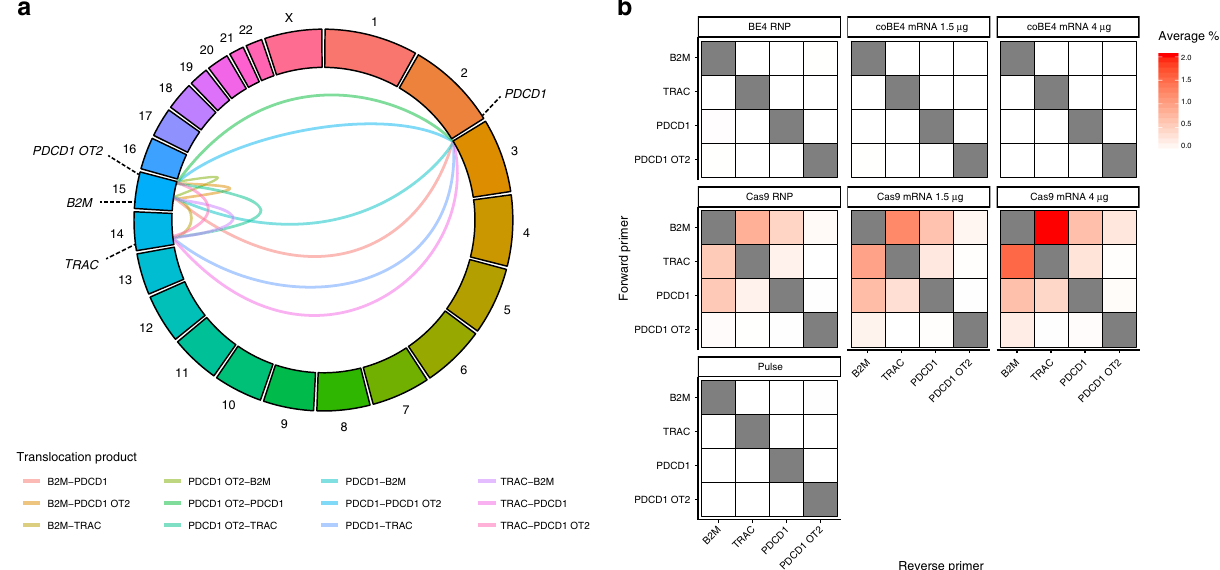
Fig. 3 Translocation frequencies in multiplex edited T cells. a Circos plot of possible translocation outcomes resulting from double-strand break induction at TRAC, B2M, PDCD1 , and PDCD1 OT site. b Droplet-digital PCR quanti fi cation of translocation frequencies. All assays run in technical duplicate across n = 2 independent biological T-cell